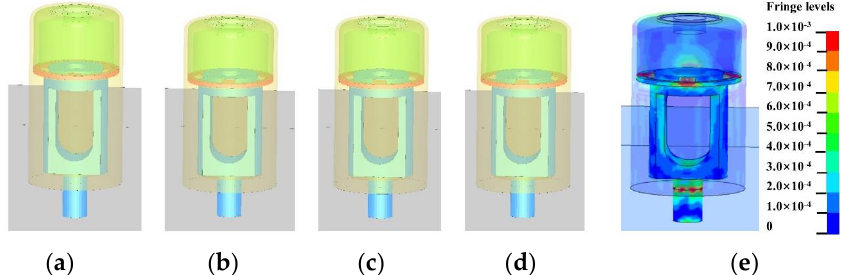
Figure 14. Simulation process of accidental drop: ( a ) t = 0 μs, ( b ) t = 64 μs, ( c ) t = 128 μs, ( d ) t = 200 μs, ( e ) stress distribution of propellant actuator at a certain time.